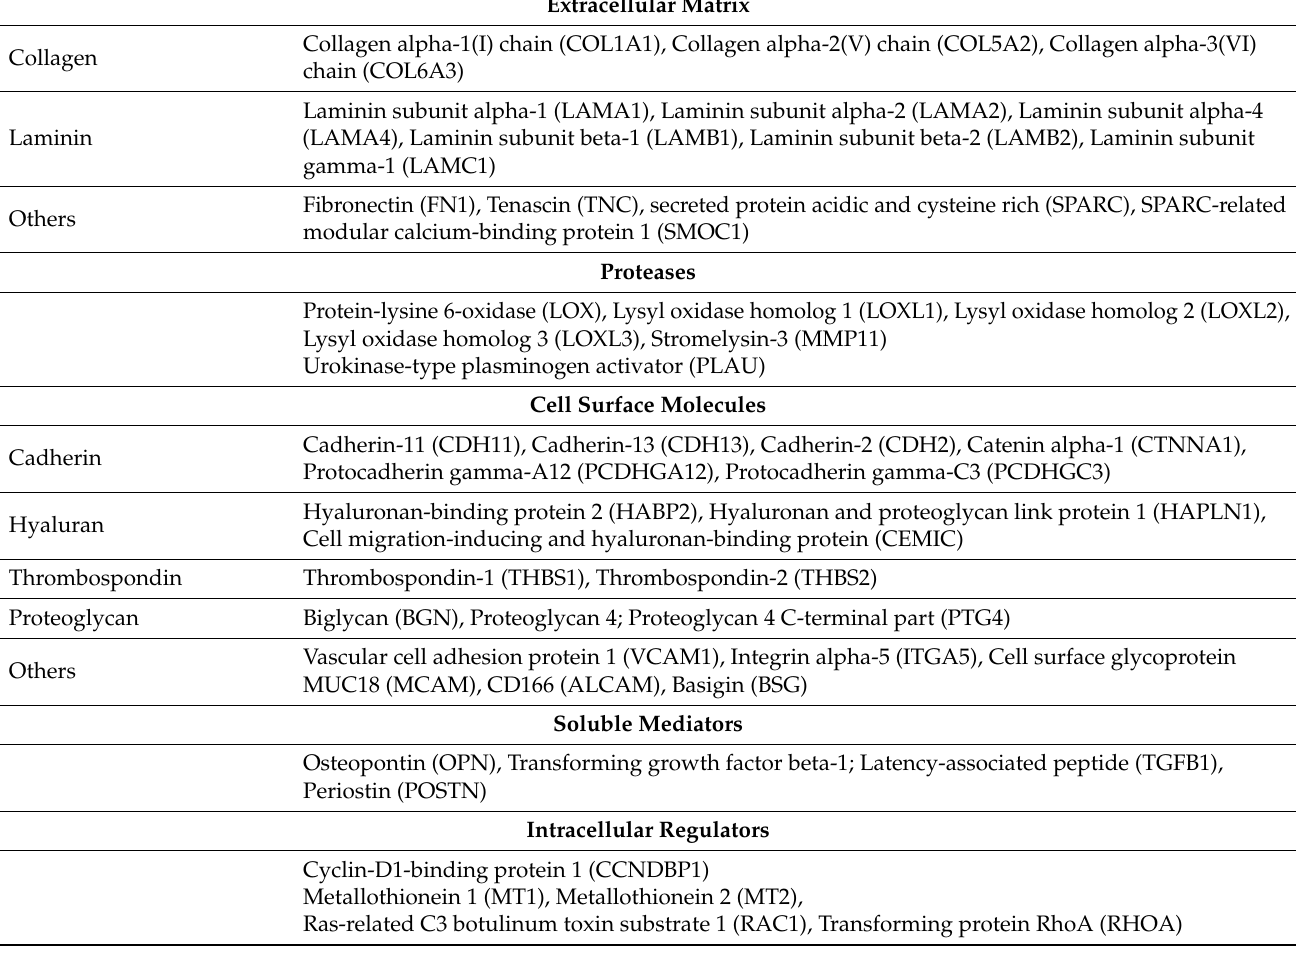
Table 5. Proteins important for the support of hematopoietic stem cells in the bone marrow stem cell niches [1–5]; a summary of relevant proteins also detected in our present proteomic study of the MSC and osteoblast secretome. Proteins being important for the molecular interactions between stem cells and normal bone marrow stromal cells or extracellular matrix molecules in the bone marrow stem cell niches were identified based on the five previous review articles. The table lists all identified proteins that in addition were detected in our present proteomic study of MSC/osteoblast